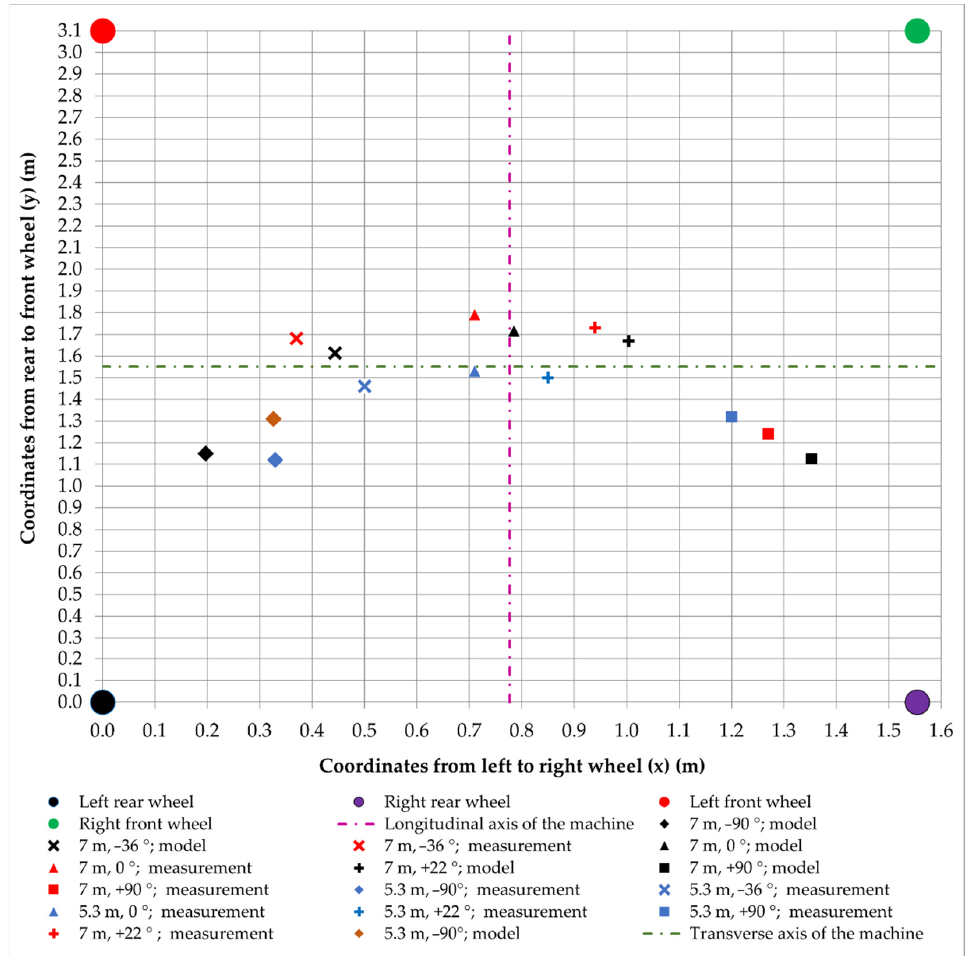
Figure 7. Centre of gravity—Position 3.